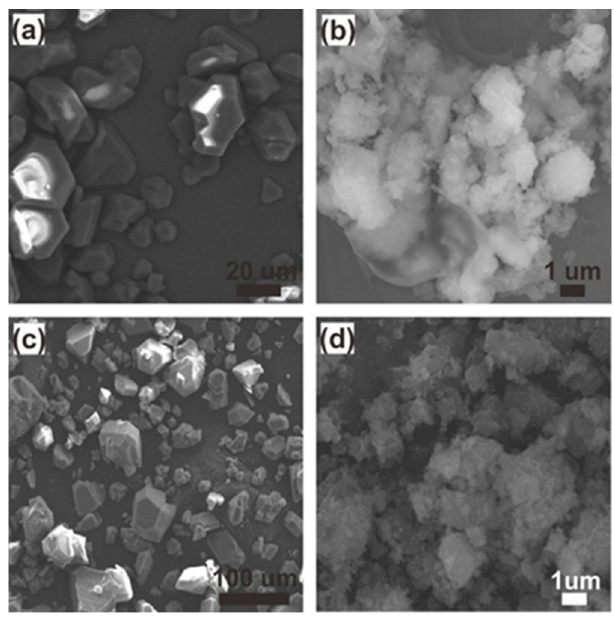
Figure 4. Scanning electron microscopy (SEM) images of ( a ) micro-sized Cu-BTC ( 1 ), ( b ) nano-sized Cu-BTC ( 2 ), ( c ) NO ⊂ micro-Cu-BTC ( 3 ), and ( d ) NO ⊂ nano-Cu-BTC ( 4